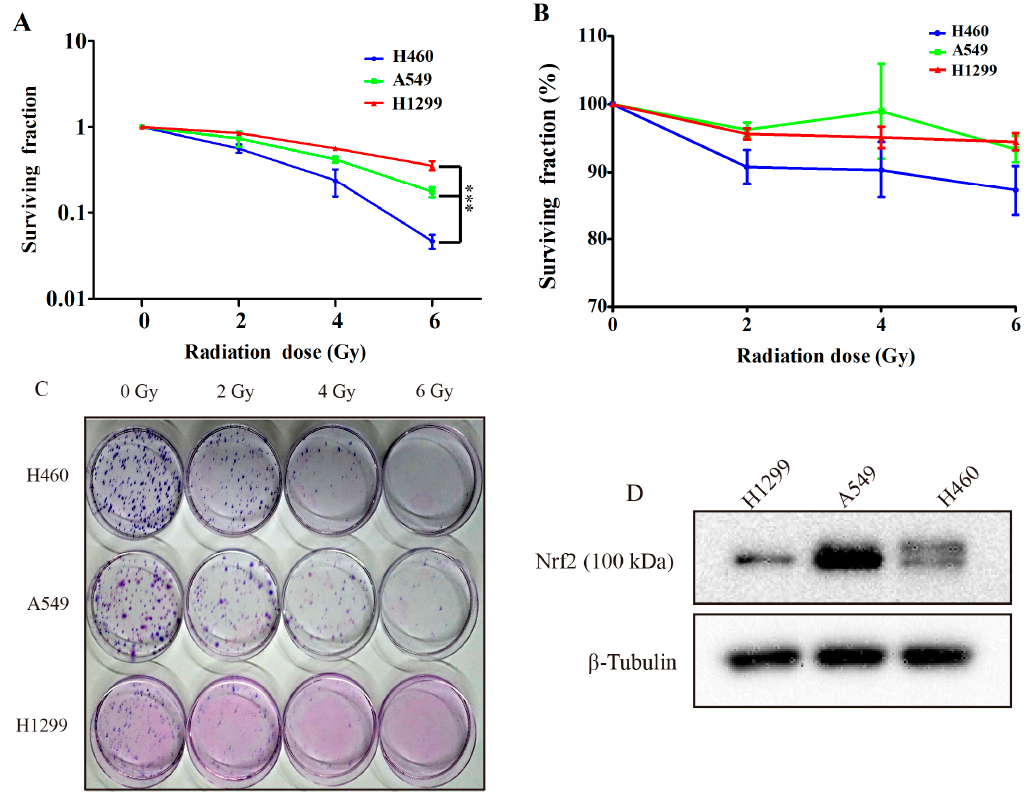
Figure 1. Differences in radiosensitivities and Nrf2 protein levels for three NSCLC cells. ( A , C ) H1299,